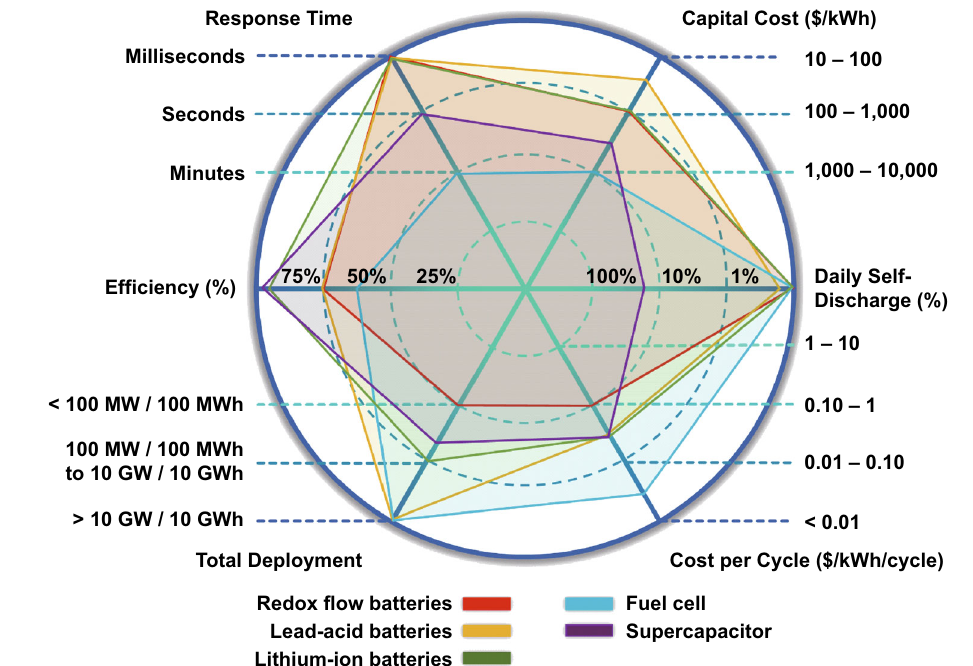
Fig. 1 Spider graph representation of critical parameters of the different electrochemical energy storage systems. Data for the figure have been obtained from Ref.